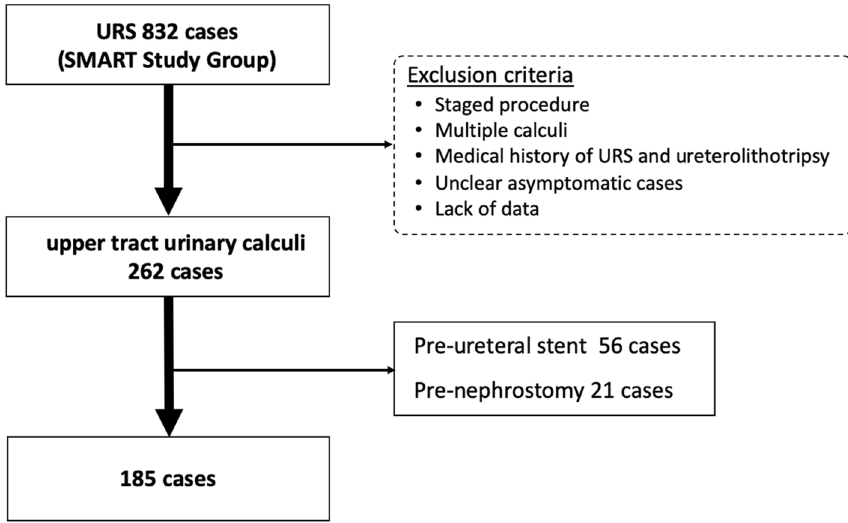
Figure 2. Flow chart of the study: Among 832 patients, 262 patients, who underwent a ureteroscopic lithotripsy (URSL) for a single ureteral stone, were analysed. All patients with planned staged procedures, multiple calculi, medical history of URS or URSL, or unclear duration until intervention were excluded. Patients who had received preoperative ureteral stent insertion (56 patents) or preoperative nephrostomy insertion (21 patients) were excluded as well. Finally, we analysed 185 patients in this